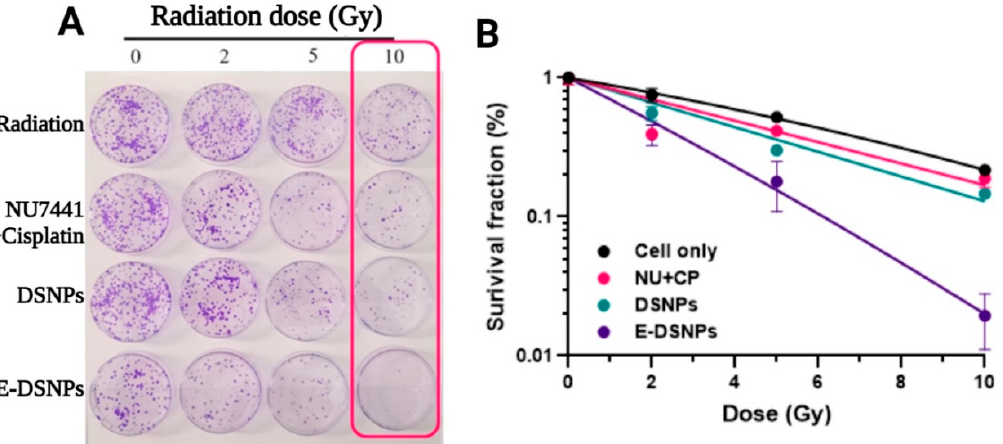
Figure 8. Colony formation assays to study the therapeutic effects of E-DSNPs. ( A ) Photomicrographs of A549 lung cancer cell colonies. ( B ) Graphs depicting survival fractions of cancer cells treated with concurrent 10 Gy radiation and dual drug loaded E-DSNPs treatment to nearly complete loss of cancer cell survival compared to that by radiation, free drugs, and dual drug loaded untargeted NPs. NU: NU7441 and CP: Cisplatin.